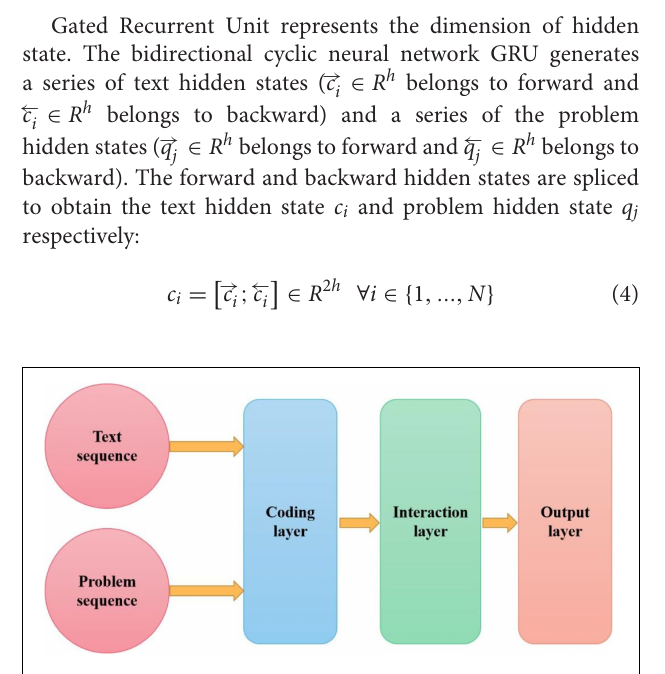
FIGURE 2 | Schematic diagram of baseline model